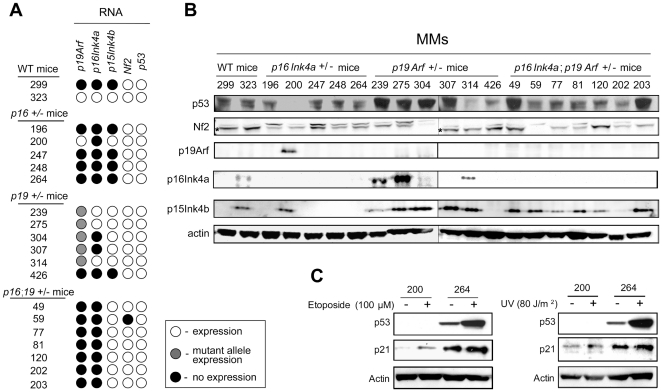
Biallelic inactivation of predisposing Ink4a and Arf tumor suppressor genes in MM.
A, Composite depicting RT-PCR for Arf exon 1β, Ink4a exon 1α, Ink4b, Nf2 and Tp53 from primary MM cells (passage ≤5). B, Immunoblotting of MM cells. Note that Arf was lost in nearly all tumors, with p53 expression being absent in the only tumor (#200) retaining Arf expression. Two bands were observed in the Nf2 immunoblot (panel 3). An asterisk beside the lower band depicts Nf2, with a non-specific band accounting for the upper signal. Actin was a loading control. C, Immunoblot of MM cells treated with Etoposide (100 µM) or UV irradiation (80 J/m2) 24 hours post-treatment.